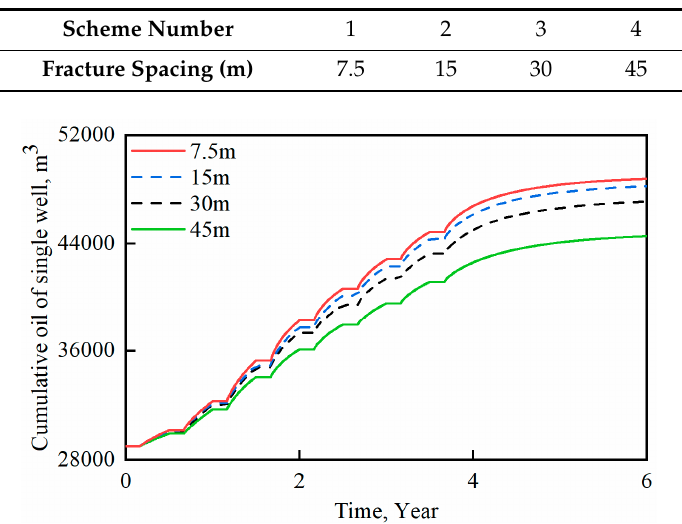
Table 14. Fracture spacing in di ff erent schemes. Table 15. Calculation results of different fracture spacing.